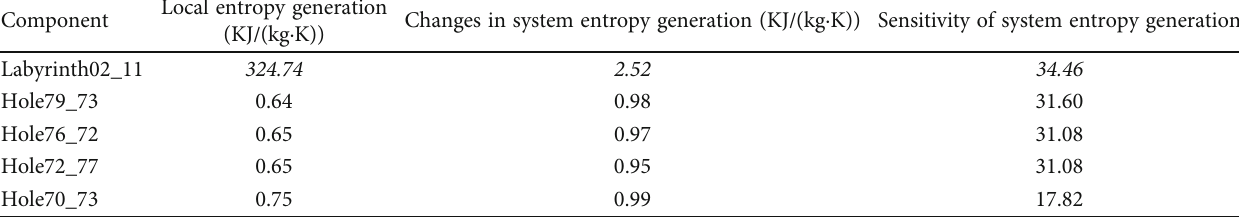
Table 2: Local entropy generation, changes in system entropy generation changes, and sensitivity of system entropy generation for di ff erent components.